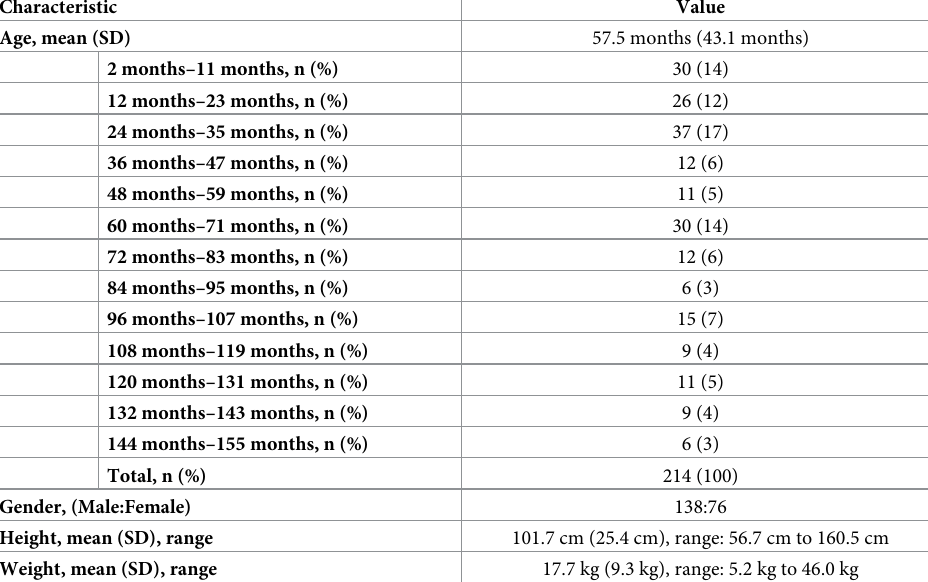
Table 1. Participant characteristics.